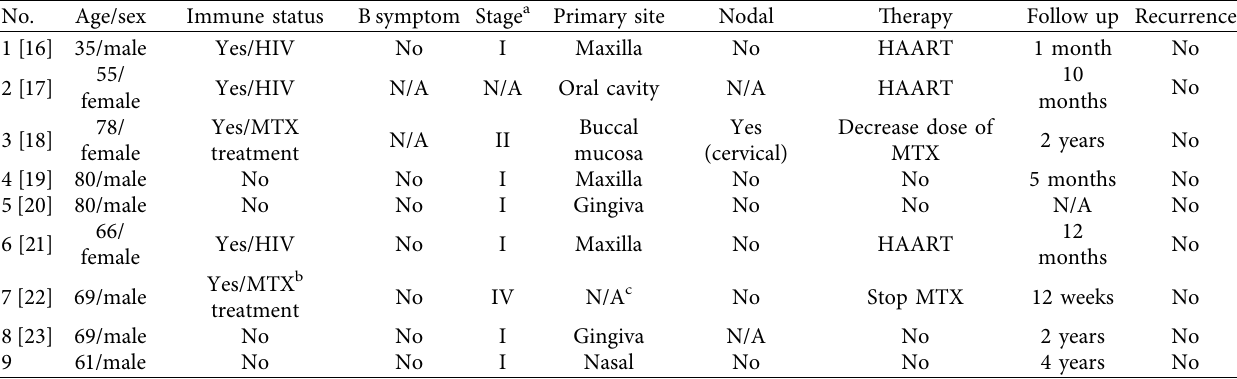
Figure 3: Initial CTshowing a mass over left frontal and ethmoid sinuses which occupied almost the entire left nasal cavity (a). Repeated CT showing regression of left nasal mass (b). Table 1: Summary of clinical characteristic of spontaneous regression of PBL cases without antineoplastic